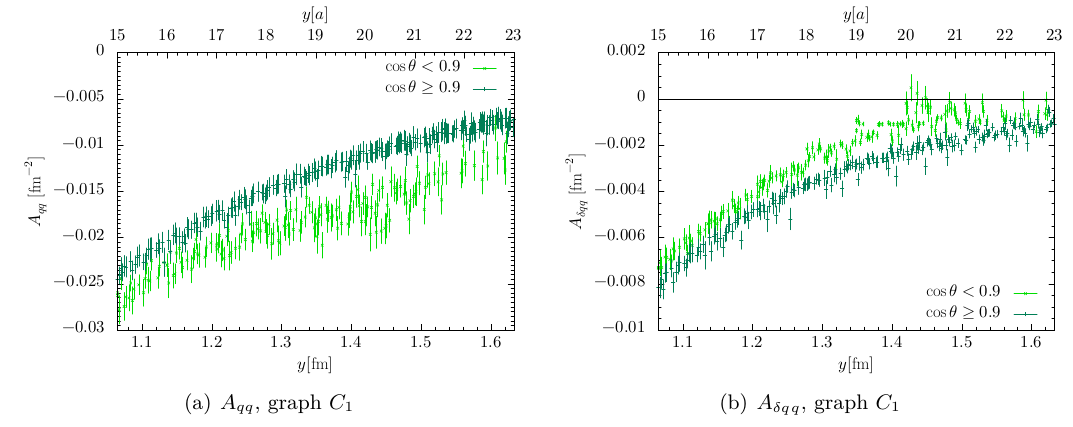
Figure 5 . Examples for the anisotropy in graph C 1 at large y = | ~y | . The data shown are for L = 40 , zero pion momentum, and light quarks. The results in this and all the following figures are given in the MS scheme at the scale µ = 2 GeV . The error bars shown in the plots are statistical and obtained with the jackknife